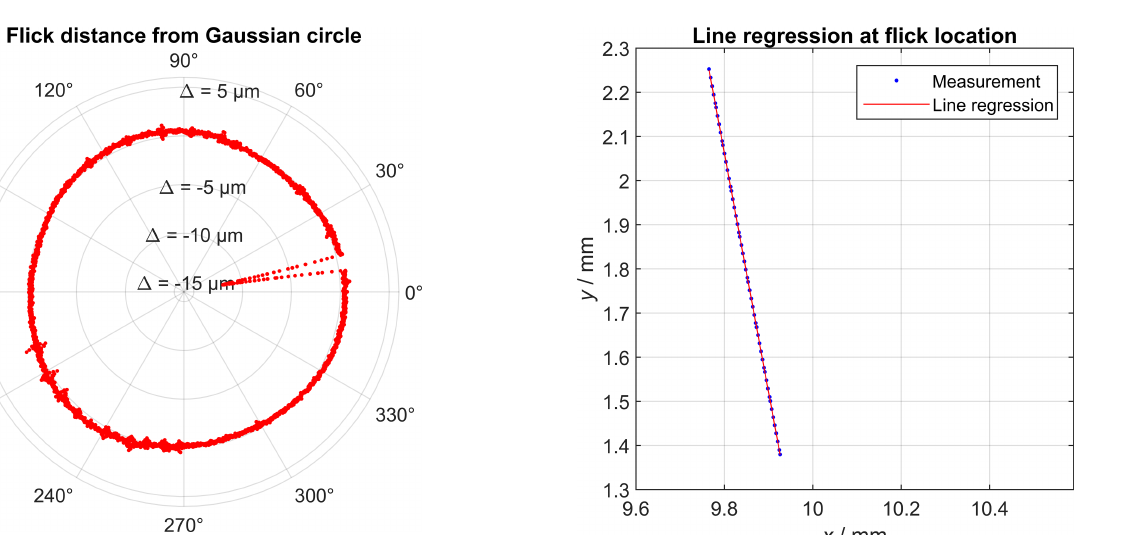
Figure 10. Robust line regression at the flick location; same coor- dinate system as Fig.